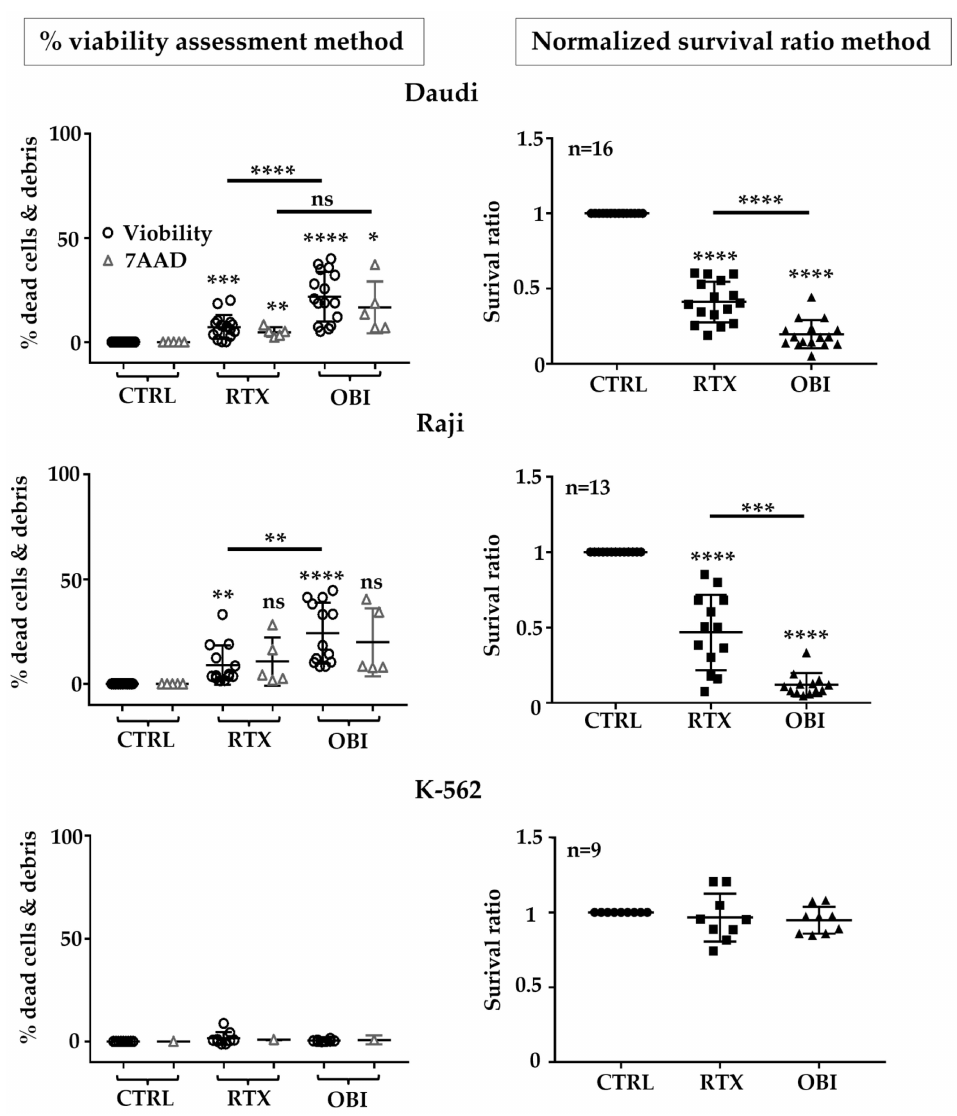
Figure 4. Using CD20 mAb-resistant MOLM-13 cells unveiled a high killing of target cells by RTX and OBI eight hours after treatment. Daudi, Raji, or K-562 cells were labeled with CTFR, whereas resistant MOLM-13 cells were with CFSE, following the provider’s instructions. Both cells were mixed at a 1-to-1 ratio and treated with RTX or OBI (10 µ g/mL) before analyzing the number of cells in the mixed and the viability of the remaining cells by 7-AAD or Viobility TM 405/452 staining (left graphs). The normalized survival ratio (right graphs) was calculated as depicted in Figure S2. Graphs show mean +/ − SD of at least 5 experiments performed in duplicate; * p < 0.05, ** p < 0.01, *** p < 0.001, **** p < 0.0001; Tukey’s multiple comparisons test compared to control or as depicted in the graphics comparing groups to each other when using the same